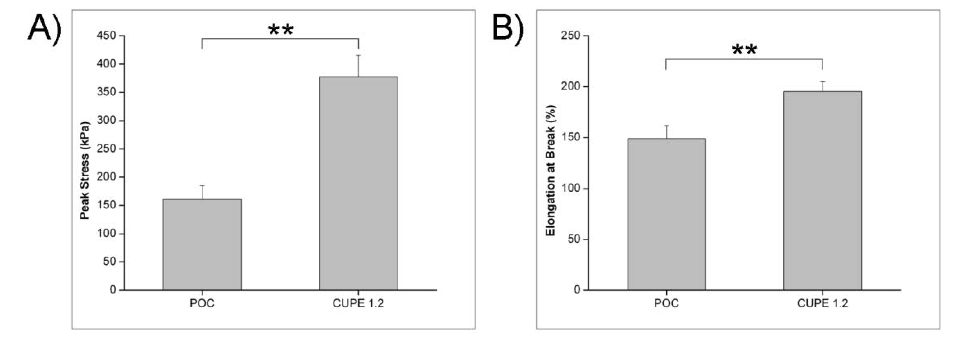
Figure 2. A comparison between single POC and CUPE 1.2 scaffold sheets. All scaffolds were post-polymerized at 80 ° C for 4 days followed by 120 ° C for 1 day under vacuum. (a) Effect of scaffold material on the peak stress. (b) Effect of scaffold material on elongation at break. ** p < 0.01; N =